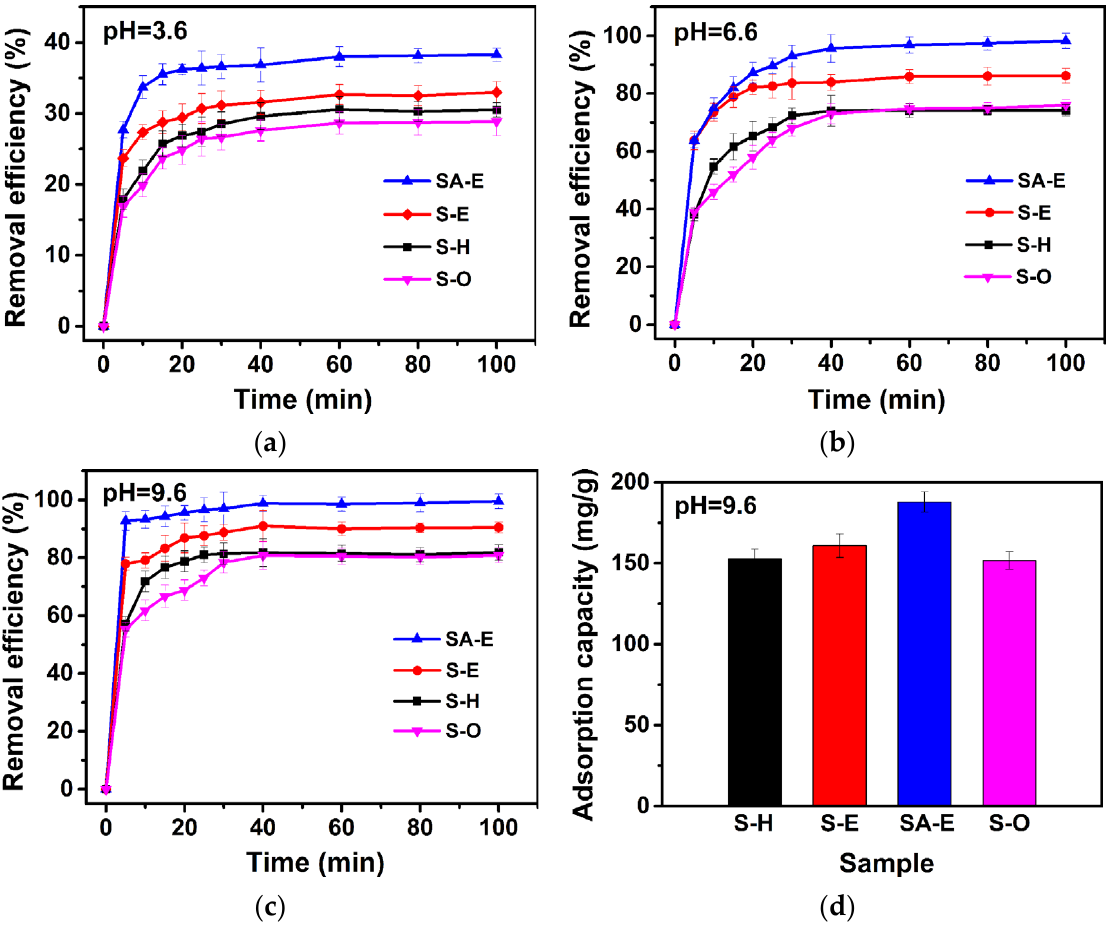
Figure 11. Effects of pH on the removal efficiency of methylene blue ( a – c ) and adsorption capacity of methylene blue ( d ) over Samples S - O, S - H, S - E, and SA - E .